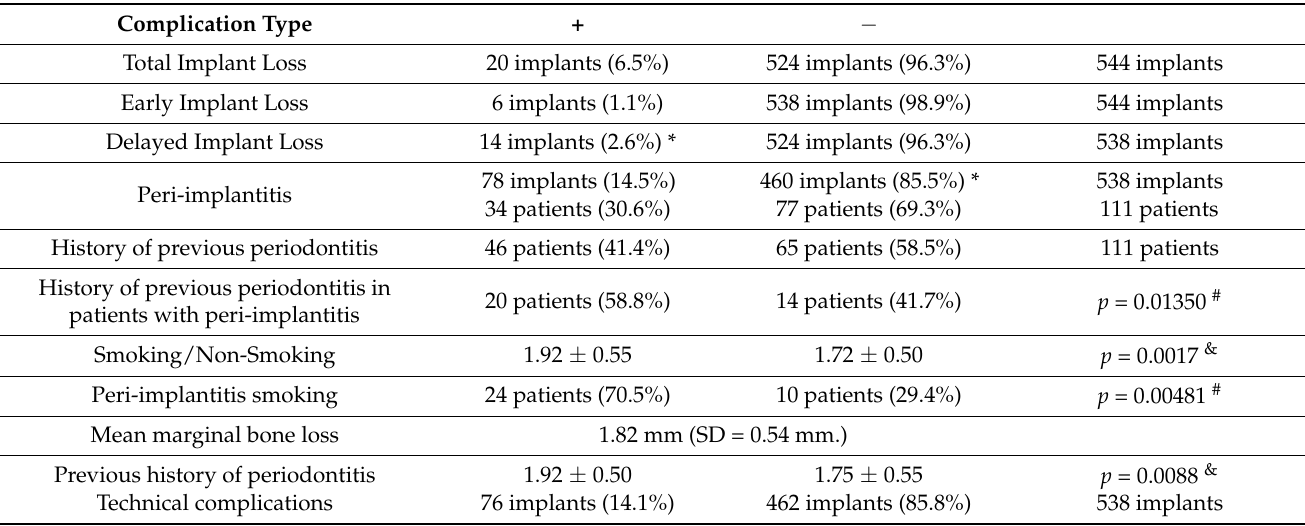
Table 4. Description of the complications presented in the implants. * all losses were due to peri- implantitis; # Chi-square test; & ANOVA